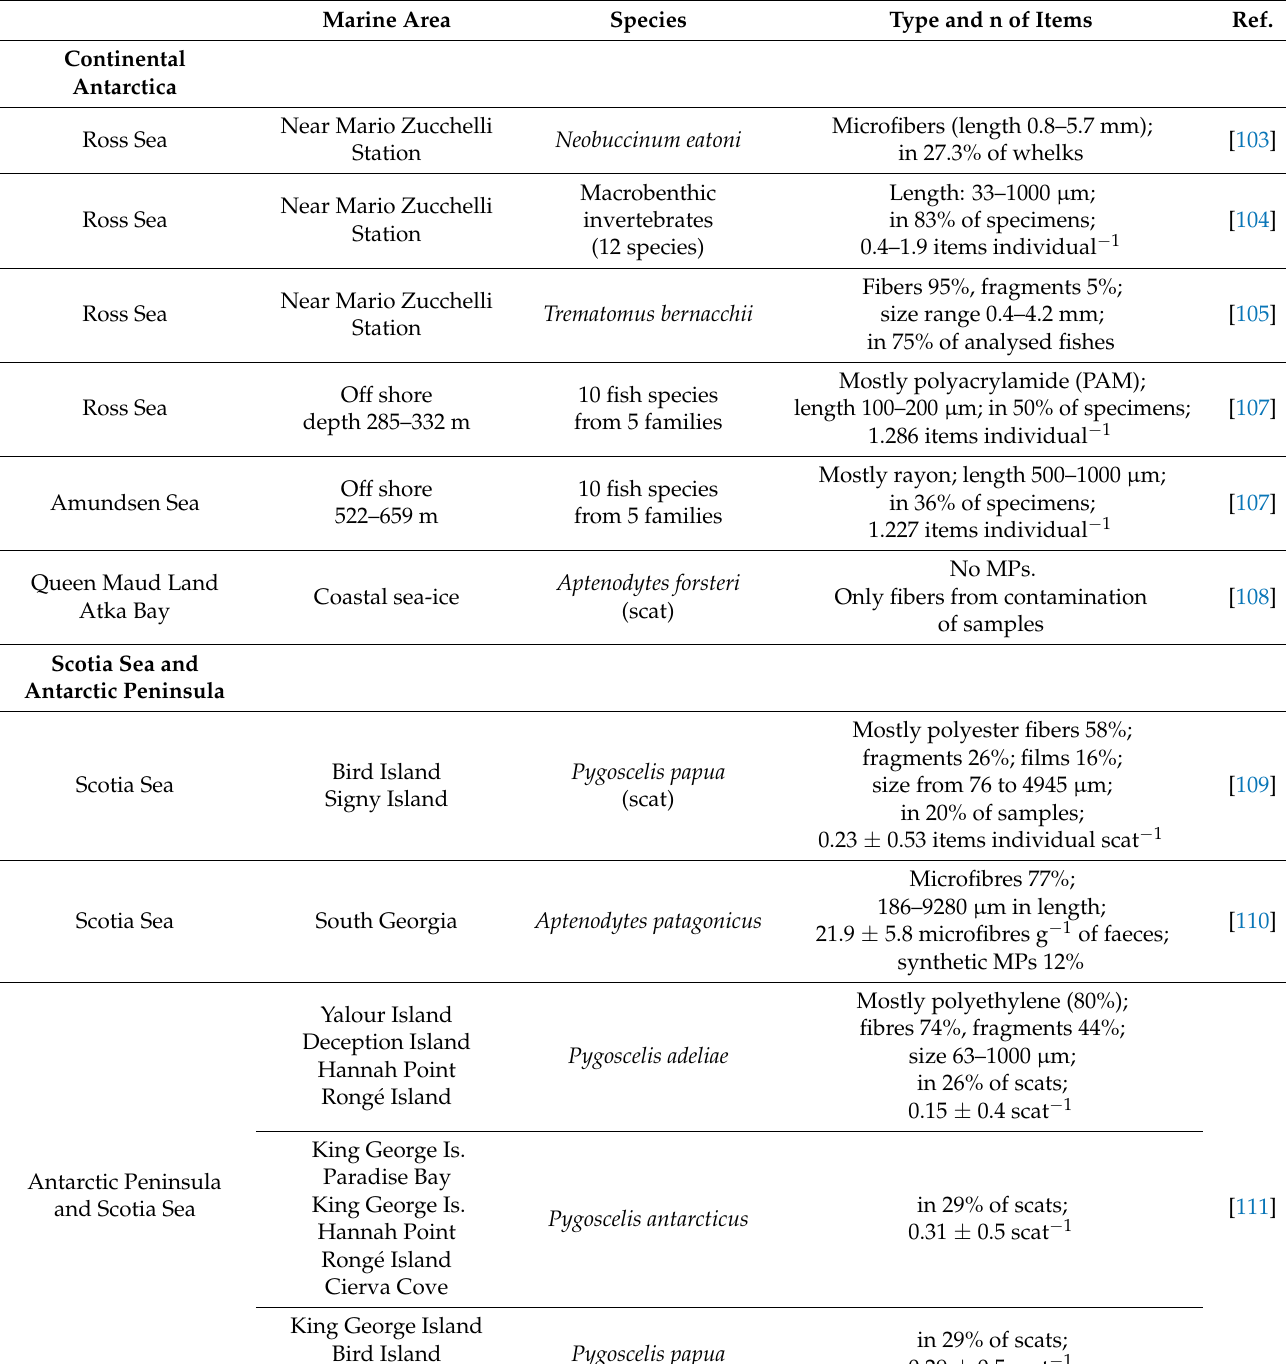
Table 2. Occurrence of plastic debris in benthic invertebrates, fish and penguin scat from continental Antarctica, the Antarctic Peninsula and the Scotia Arc. Marine Area Species Type and n of Items